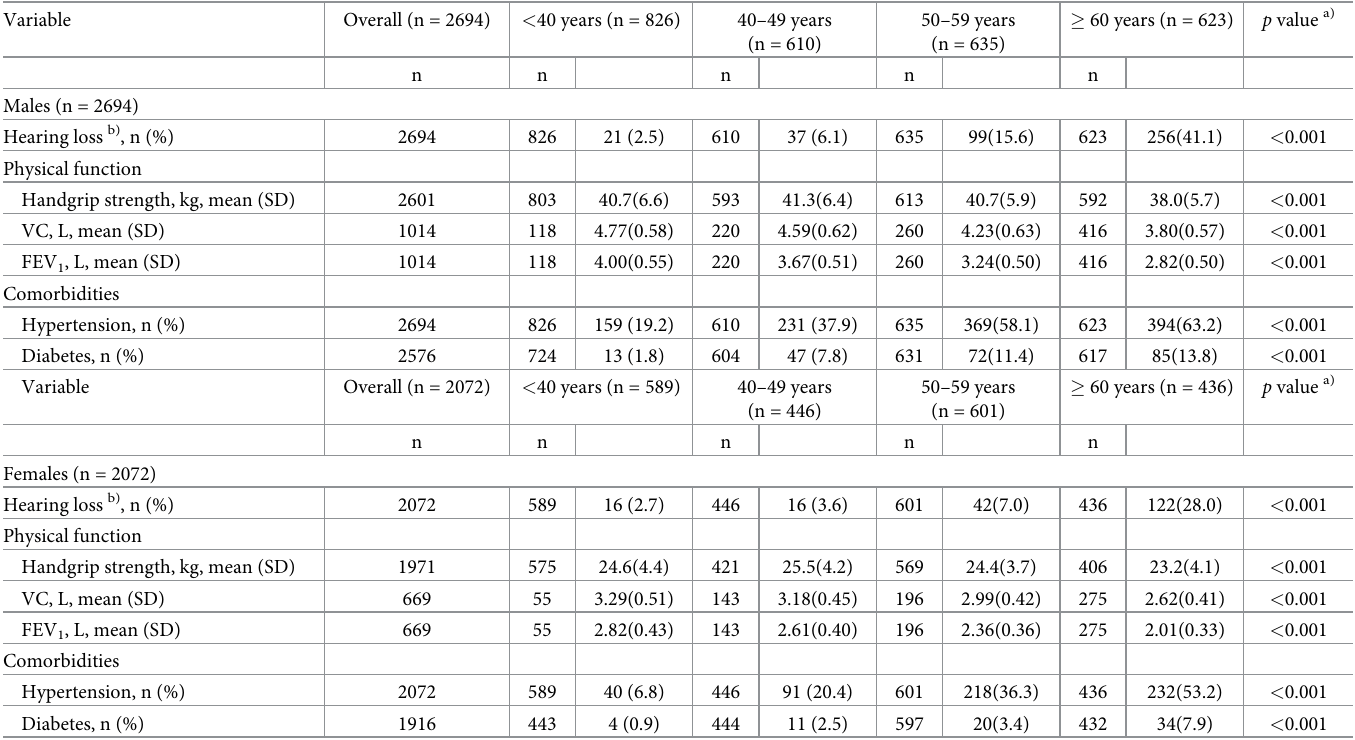
Table 2. Hearing loss, physical function and comorbidities stratified by age and sex (n =